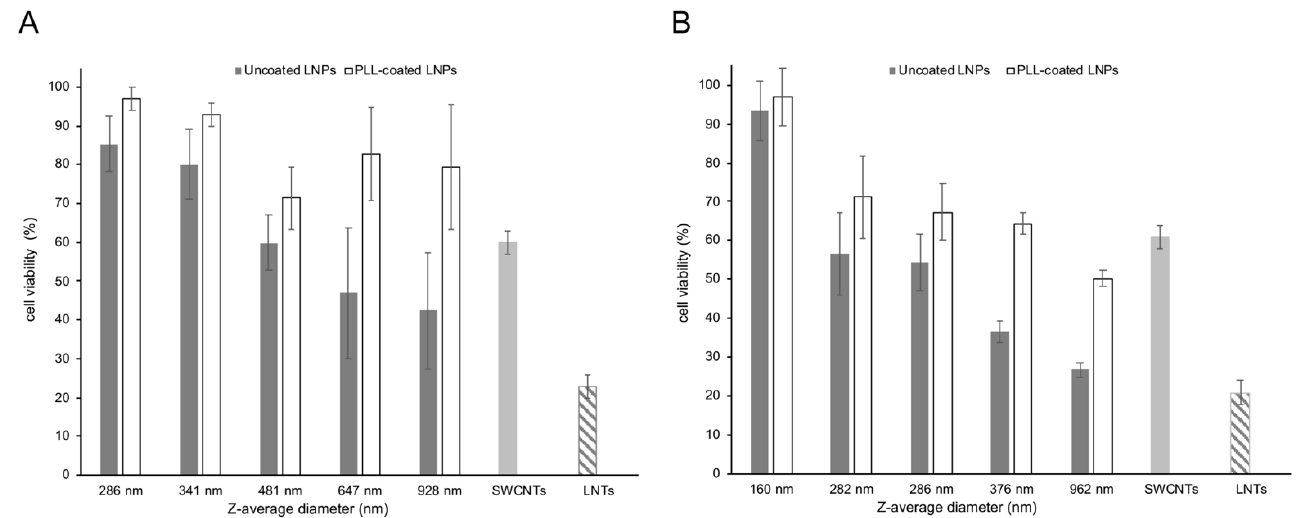
Figure 5. Cytotoxicity of LNPs of different sources and diameters determined with the Cell Count Kit-8 on A549 cells. The vertical axis displays cell viability (%). ( A ) Uncoated and PLL-coated birch BioLignin™ nanoparticles. ( B ) Uncoated and PLL-coated wheat BioLignin™ nanoparticles. For comparison, SWCNTs (light gray bars) and LNTs prepared from poplar TGA lignin (hatched bars) were included. The error bars represent the standard deviation of three replications.